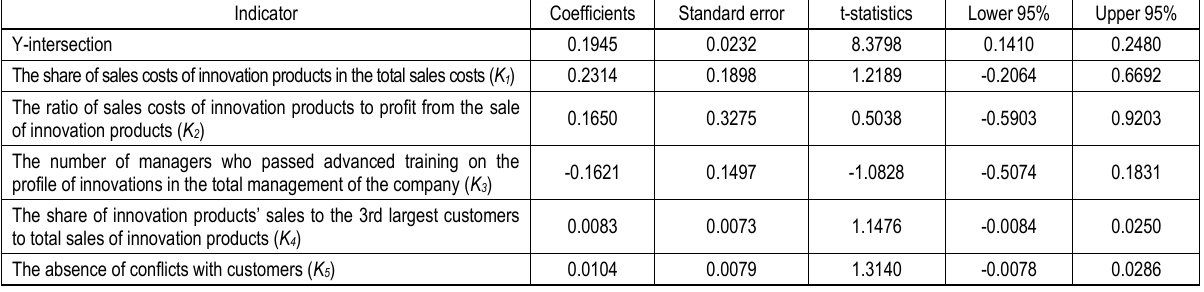
Table 1. Results of statistical analysis of dependence profitability of innovation products sales of LCC “ Turbomash ” of influence instruments on this